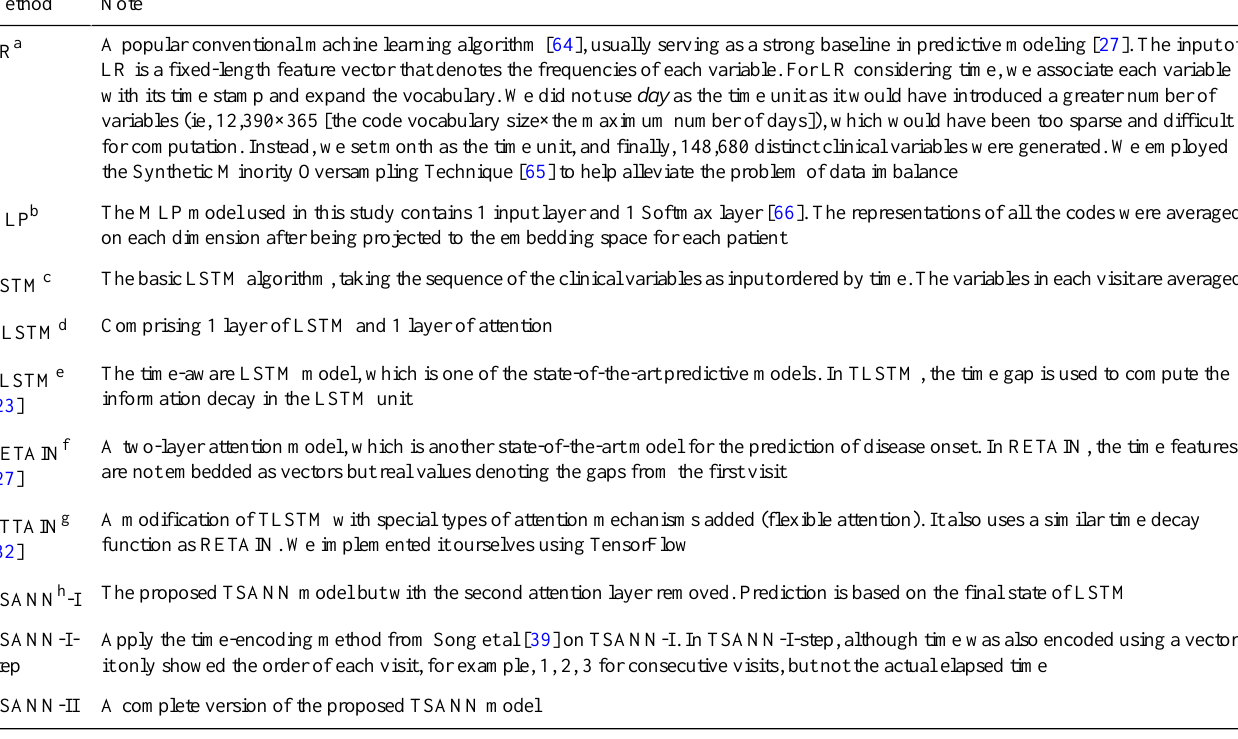
Table 2. The methods used for